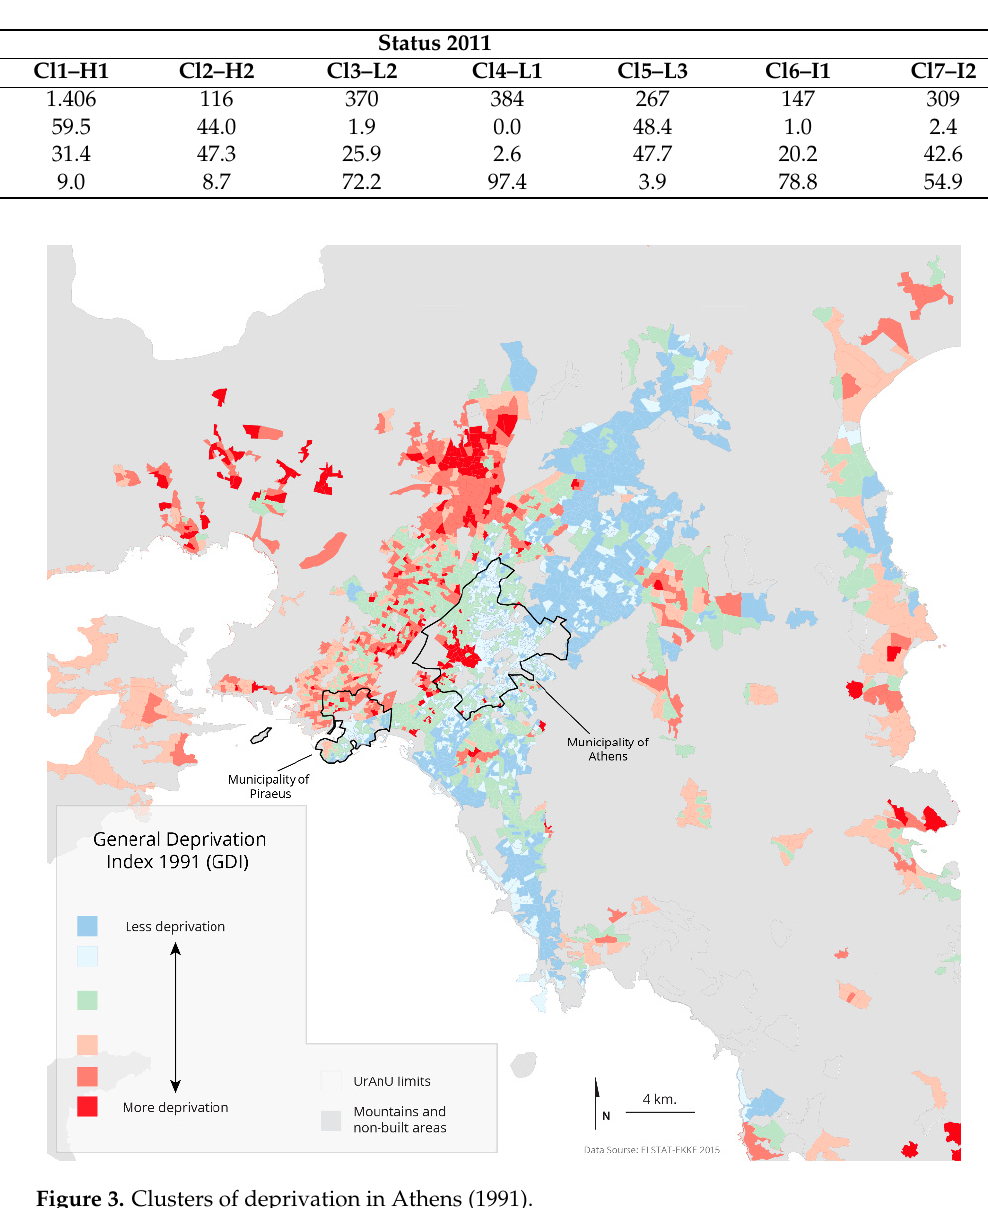
Table 5. Distribution of Athenian spatial units (URANU) within the 2011 deprivation clusters by their respective deprivation status in 1991.